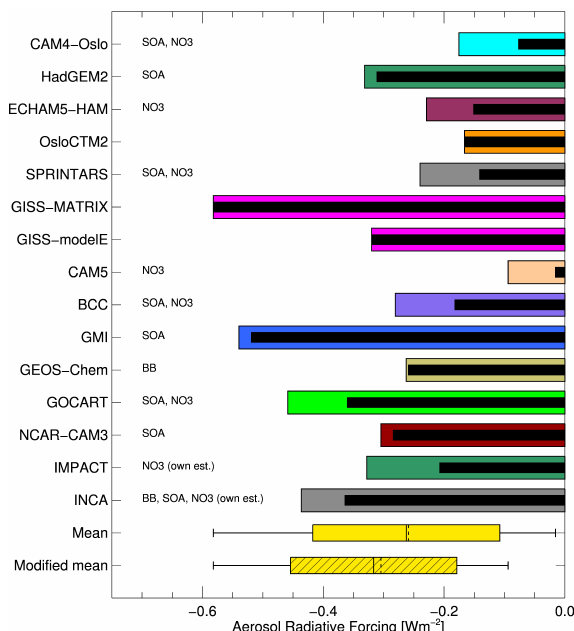
Fig. 5. Model total RFs. Black bars show the bare modelled forc- ing, the colored bars show the forcing modified for untreated com- ponents (see text for details). The yellow bar shows the AeroCom mean of the total RF of DAE. Solid lines inside the boxes show the model mean, dashed lines show the median. The boxes indicate one standard deviation, while the whiskers indicate the max and min of the distribution. The yellow shaded bar shows the AeroCom mean when aerosol component adjustment is made for missing aerosol components.